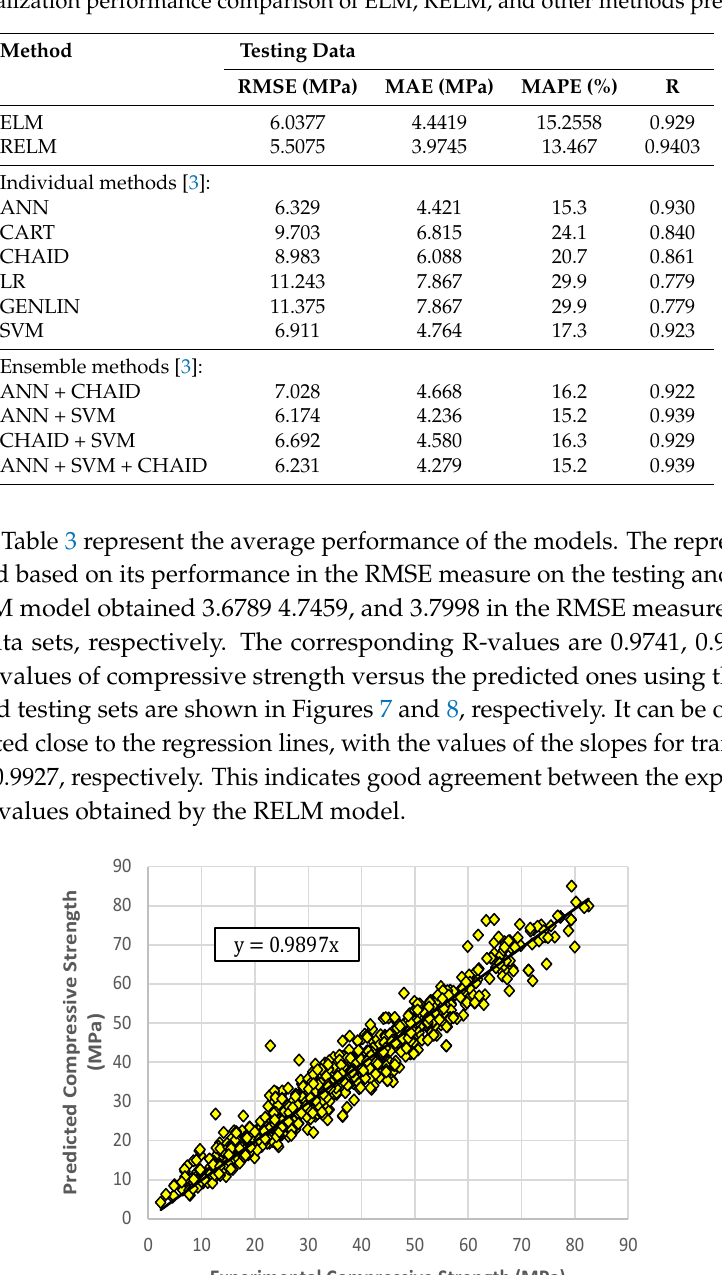
Table 5. Generalization performance comparison of ELM, RELM, and other methods presented in [3].